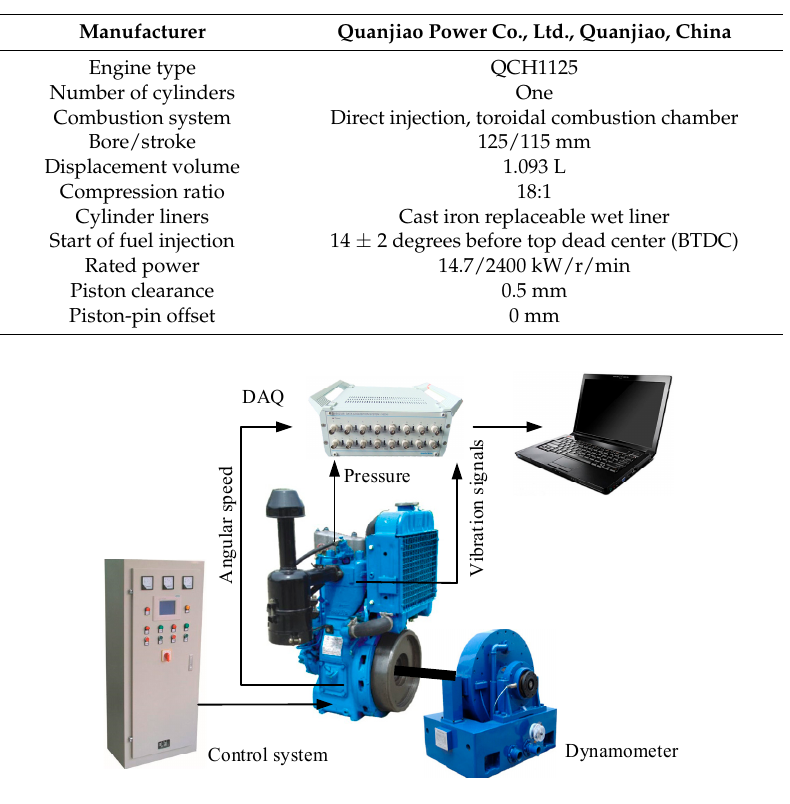
Figure 18. Schematic of the diesel engine test rig.